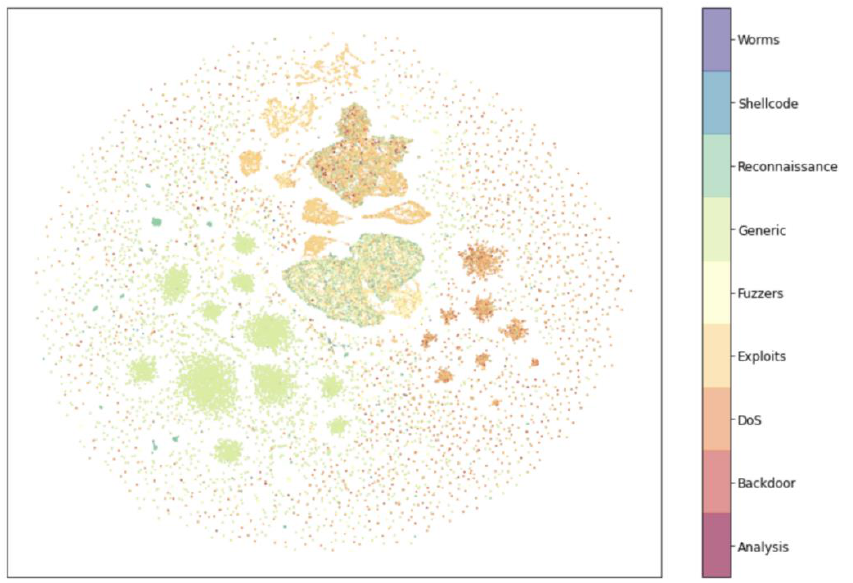
Figure 11. Visualization of multi-classification effect based on hybrid algorithm UMAP-RF.